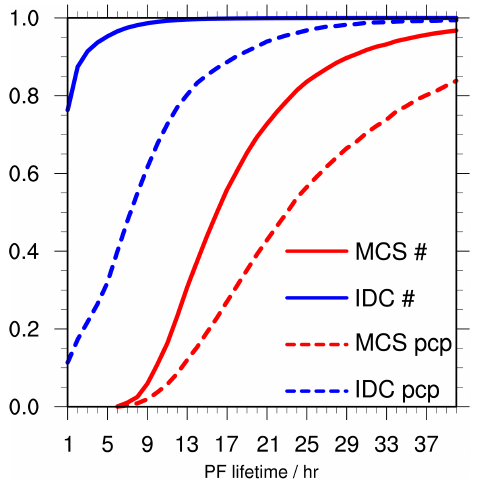
Figure 10. Cumulative distribution functions of PF-based lifetimes for MCS and IDC events and their associated precipitation in the data product domain for 2004–2017. The red solid line is for the number of MCSs, the red dashed line for MCS-associated precipi- tation, the blue solid line for the number of IDC events, and the blue dashed line for IDC-associated